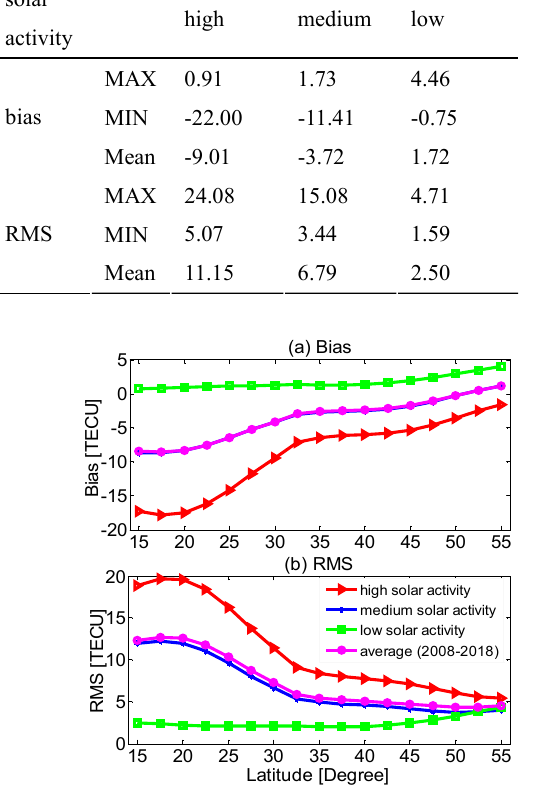
Fig.3 Bias and RMS during high, medium and low